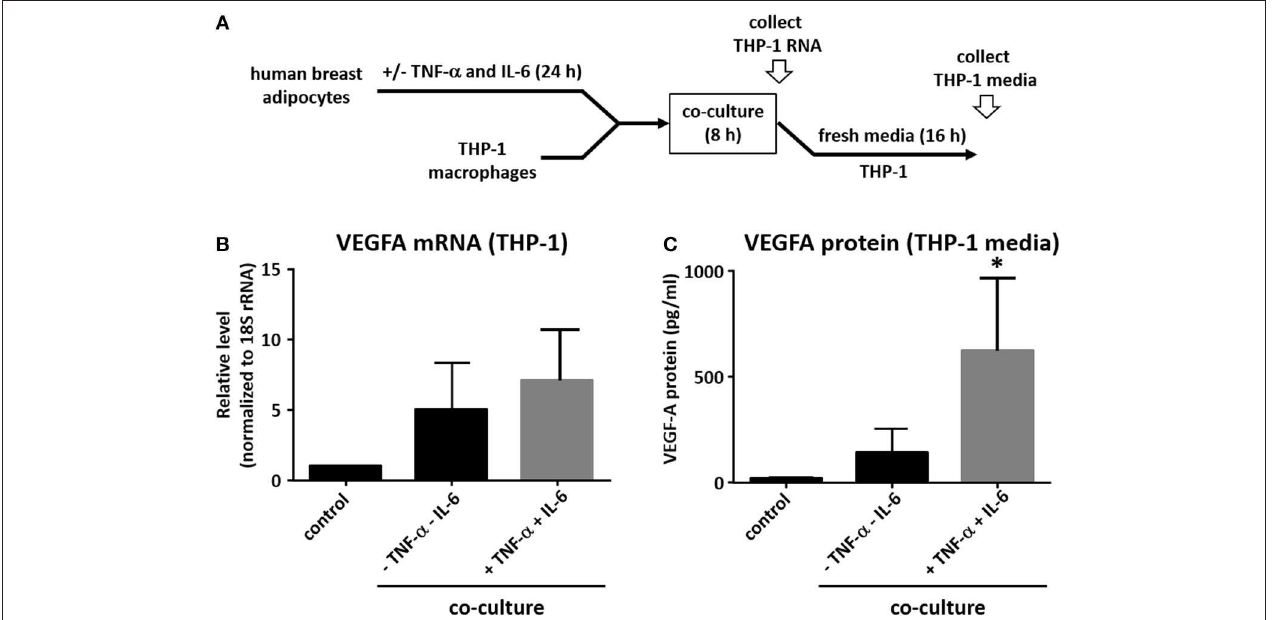
FIGURE 3 | Pre-treatment of adipocytes with IL-6 and TNF- α potentiates effect on macrophage VEGFA expression. (A) Differentiated primary human breast adipocytes were treated with TNF- α and IL-6 (10ng/mL each) for 24h before co-culture with PMA-treated THP-1 using a Transwell system for 8h. (B) Macrophage RNA was collected, reverse transcribed, and qPCR performed with 18S and VEGFA primers. (C) Macrophages were co-cultured with pre-treated adipocytes as above for 8h then changed to new media for 16 additional h before supernatant was collected and analyzed for secreted VEGFA protein ( n = 3, * p < 0.05 as compared to co-culture without pre-treatment); statistical analyses were performed using standard deviation and the unpaired Student’s t